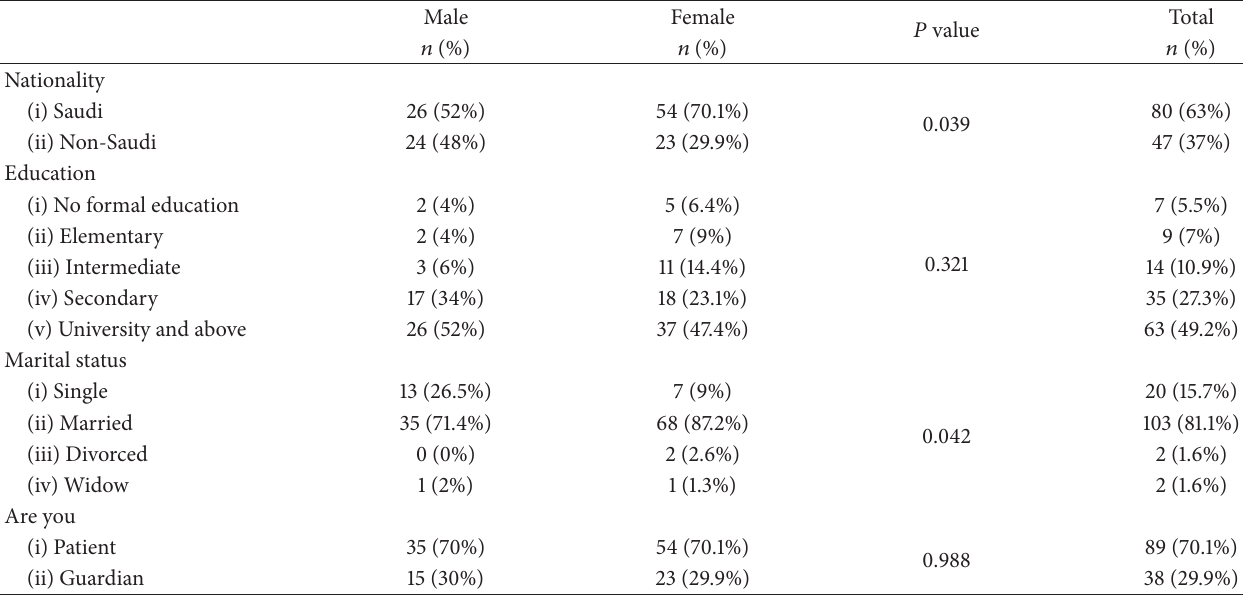
Table 1: Participant demographic